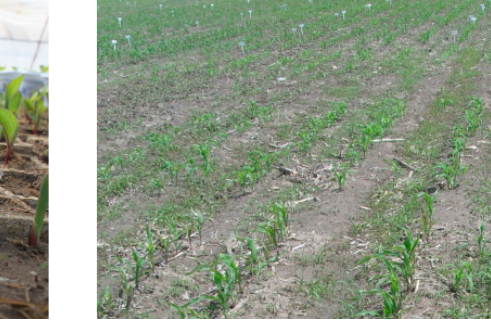
Figure 5. Effect of transplanting in the